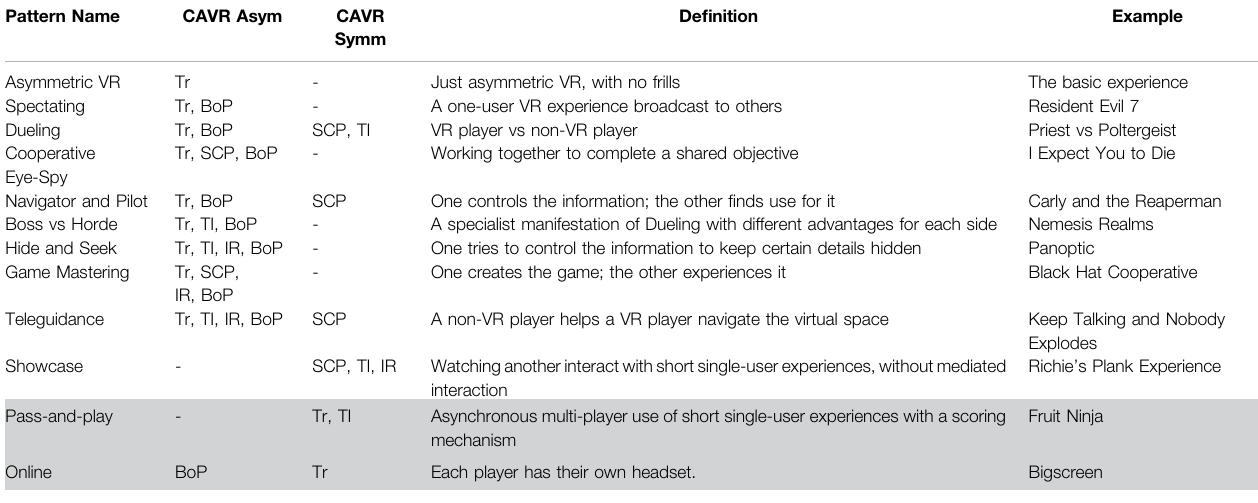
TABLE 4 | Patterns of asymmetry, identi fi ed by content analysis of Reddit posts, and their de fi nitions. Shaded rows are excluded from further analysis. Pattern